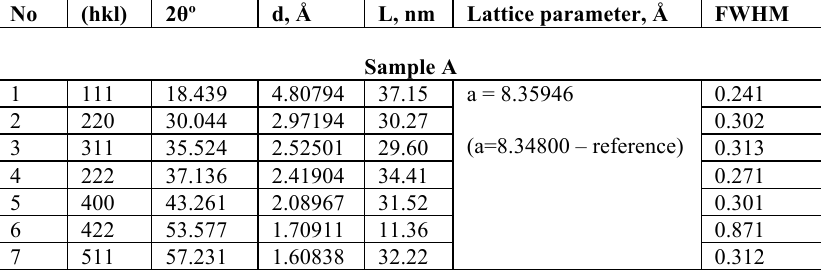
Table 1. XRD data for Fe